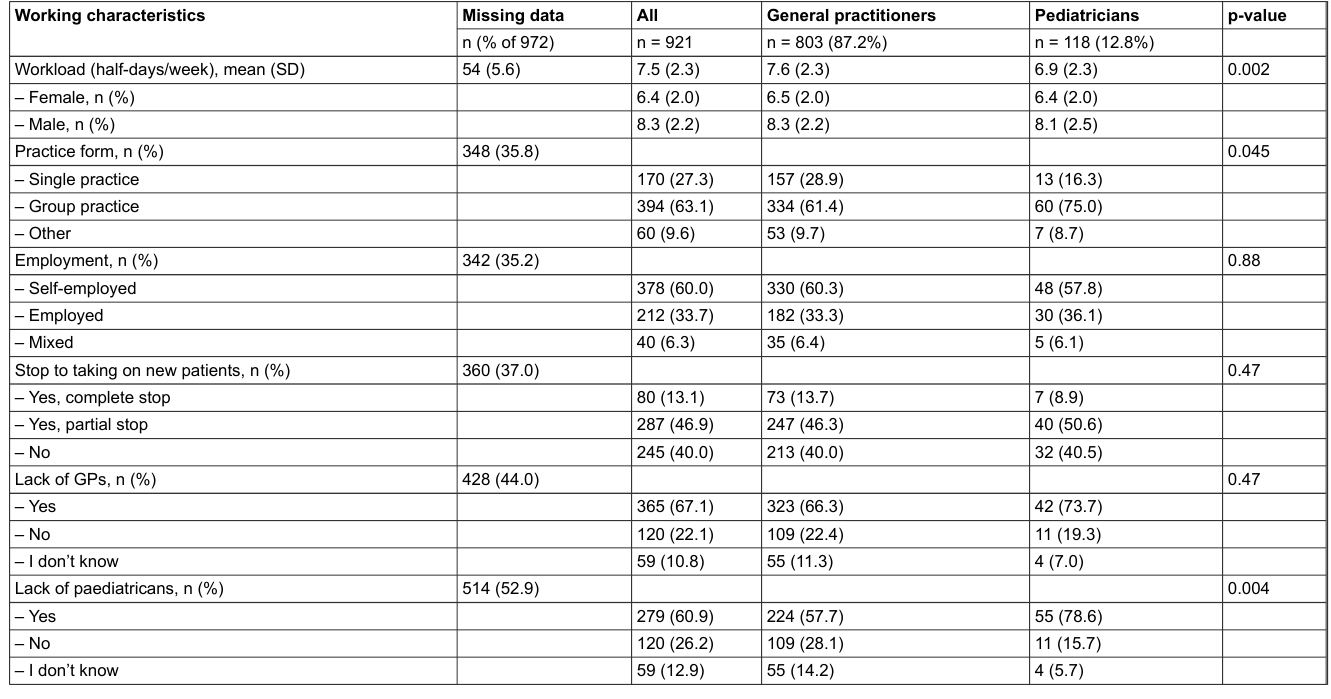
Table 2: Working characteristics as reported in the questionnaire by 921 primary care physicians (95%). Working